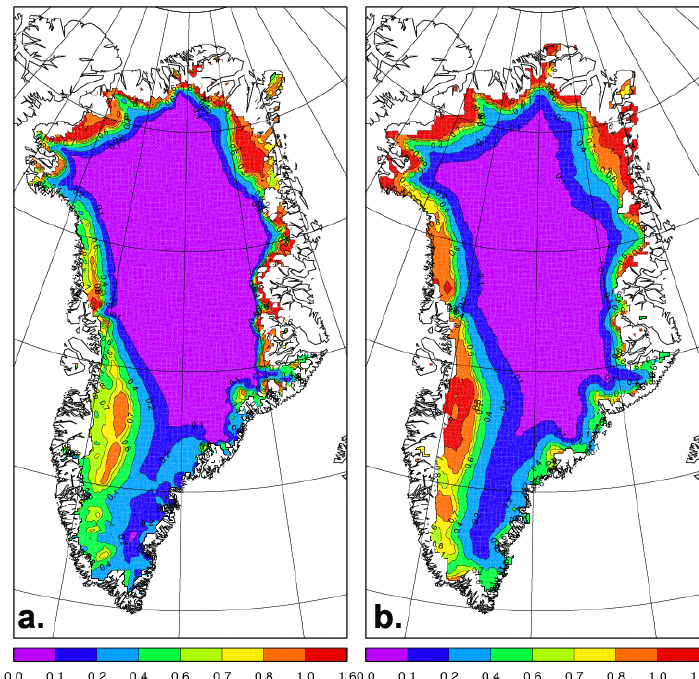
Fig. 13. Fraction of refreezing over snowfall ( E r /C ) from RACMO2 (a) and MAR (b) fields.